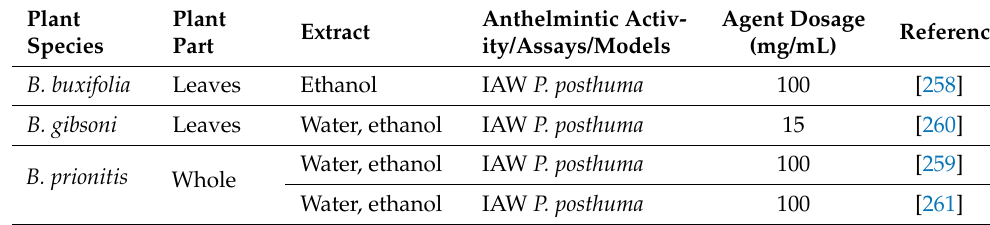
Table 10. Anthelmintic activities of extracts from species within Barleria